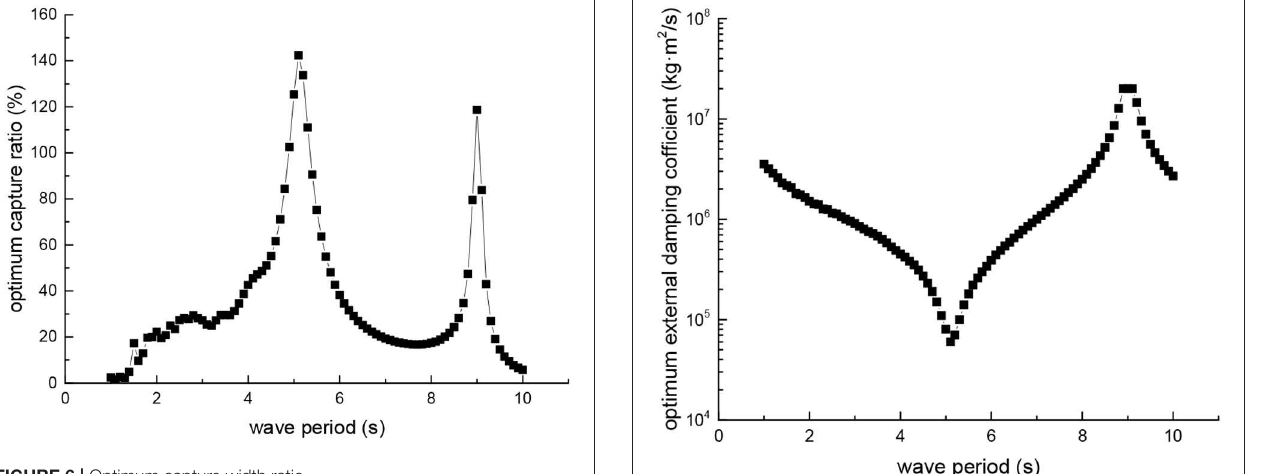
FIGURE 6 | Optimum capture width ratio.